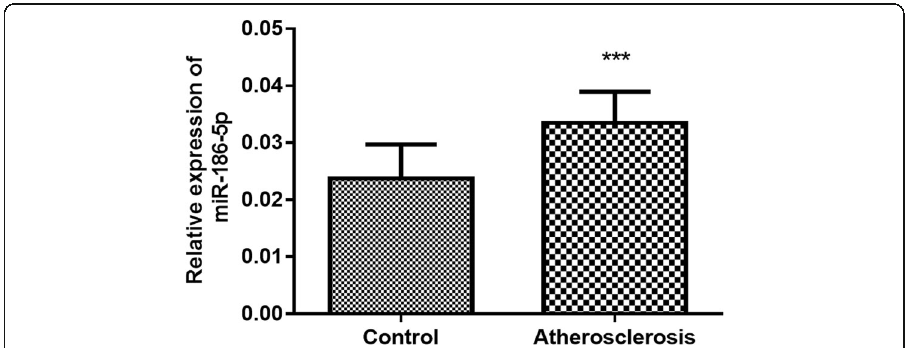
Fig. 1 The expression level of miR-186-5p was significantly higher in atherosclerosis patients than in the controls. *** p <